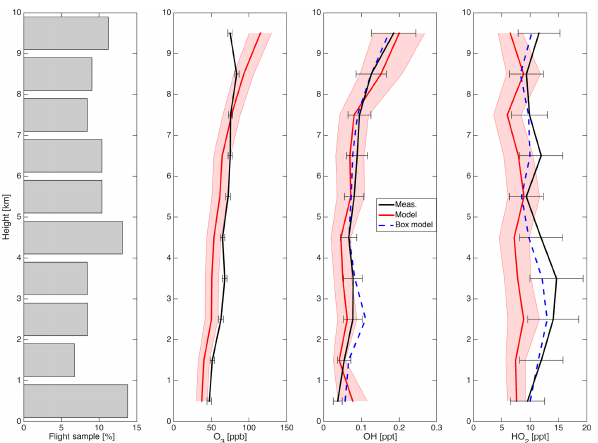
Figure 5. Vertical profiles of median modeled (red) and measured (black) ozone, OH, and HO 2 for Anchorage-based INTEX-B flight data binned by kilometer. Gray bar graph shows percent of flight data within each vertical bin. Shaded regions represent 1 σ of the model ensemble; error bars on measurements are uncertainty at 1 σ confidence. Blue line represents results from the box